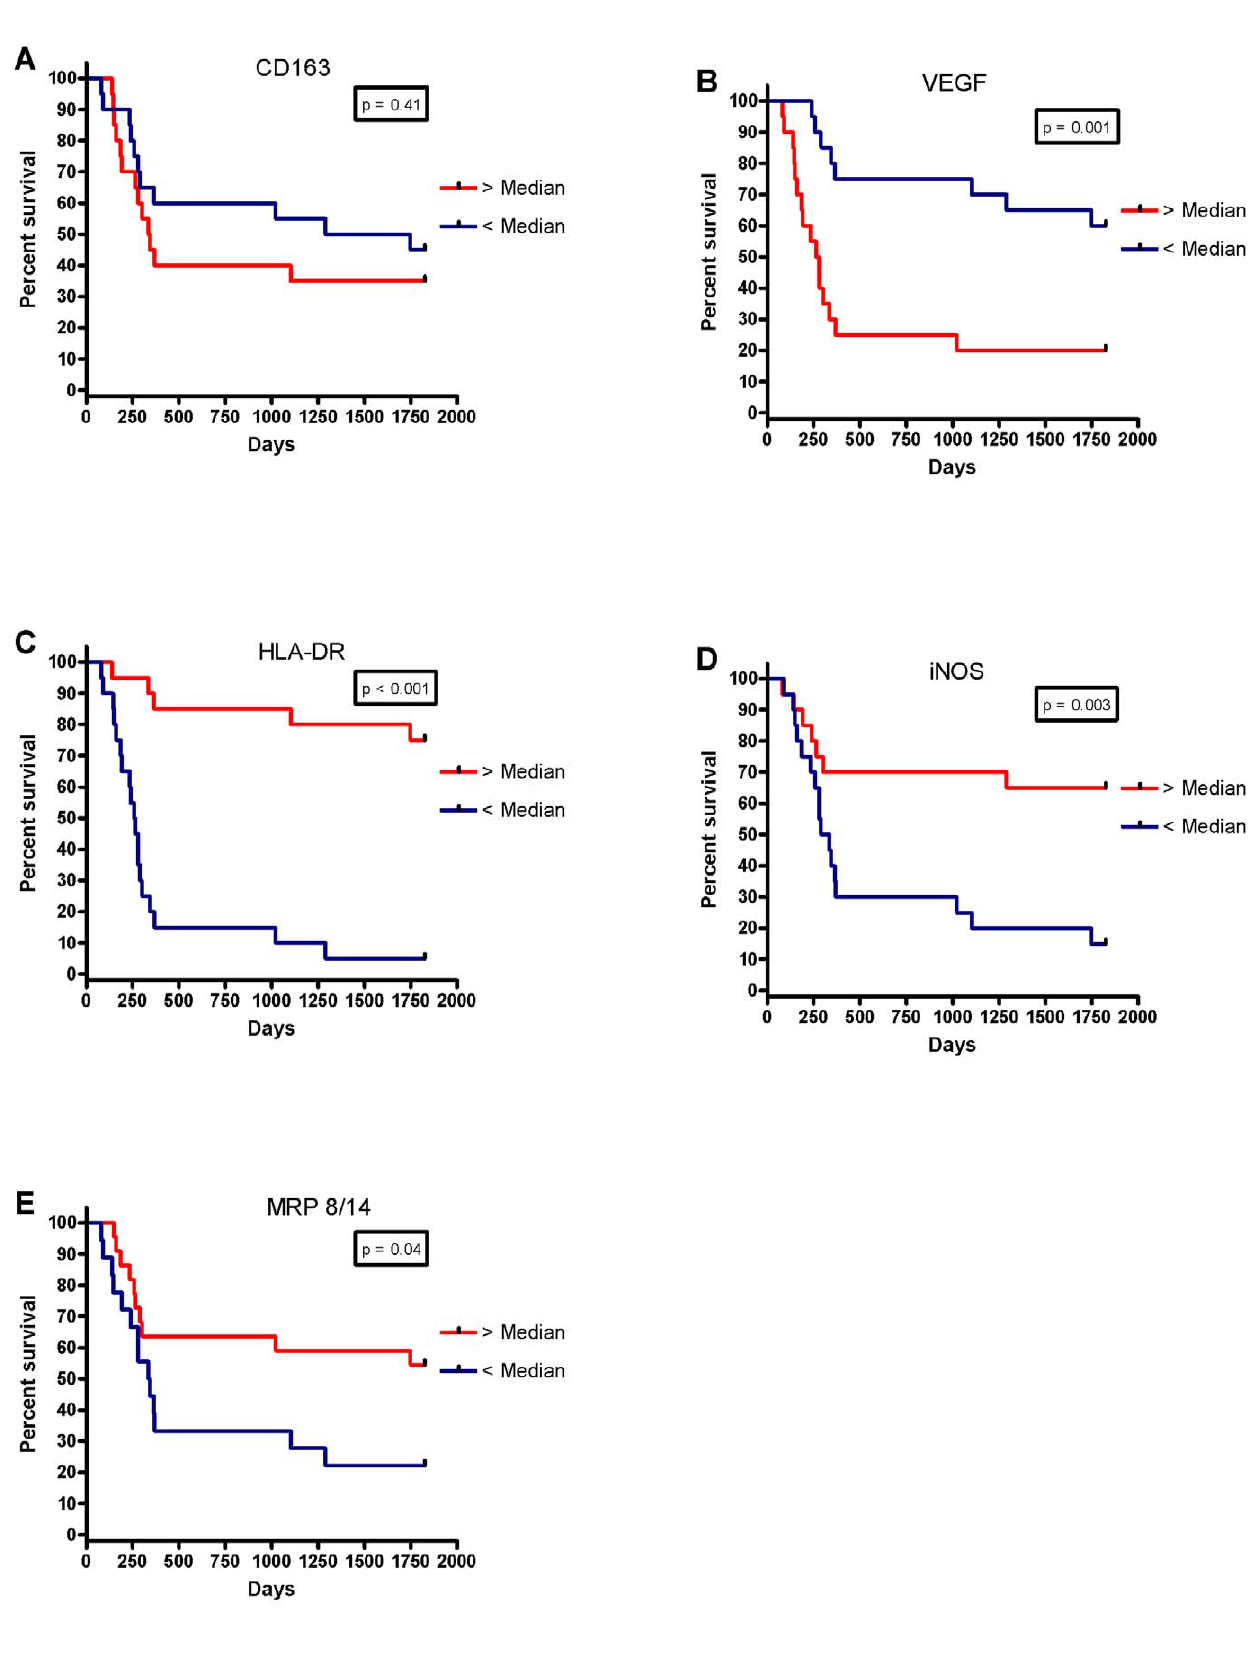
Figure 4. Kaplan-Meier five year survival curves for non-macrophage densities in the tumour islets for (A) CD163, (B) VEGF, (C) HLA-DR, (D) iNOS and (E) MRP 8/14. doi:10.1371/journal.pone.0021874.g004 PLoS ONE |